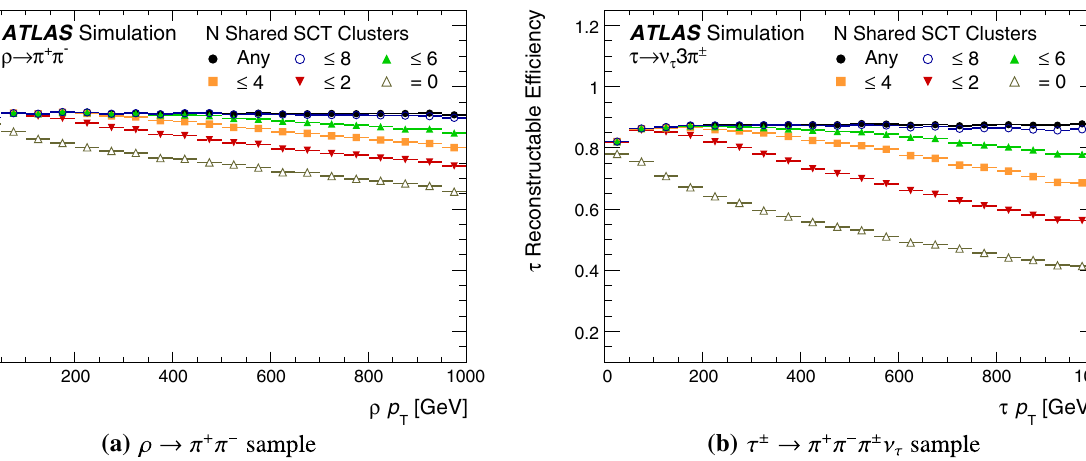
number of shared clusters allowed on a track candidate assuming all the merged pixel clusters have been identified as merged. It is required that the stable charged particles are created before the